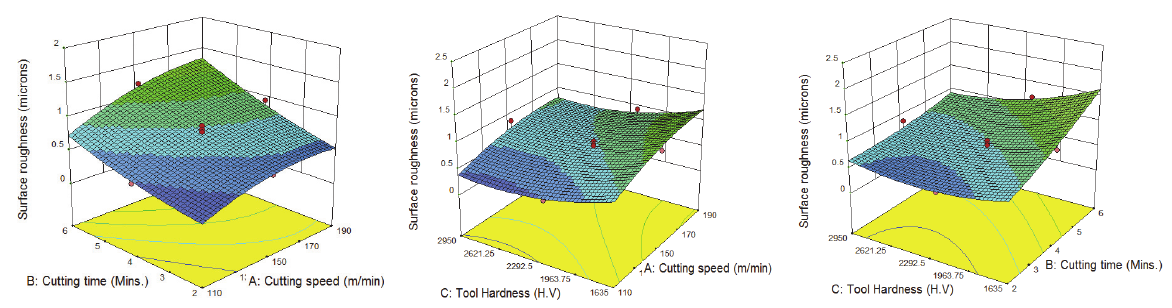
Fig. 6 . Effect of cutting speed and cutting time on surface roughness